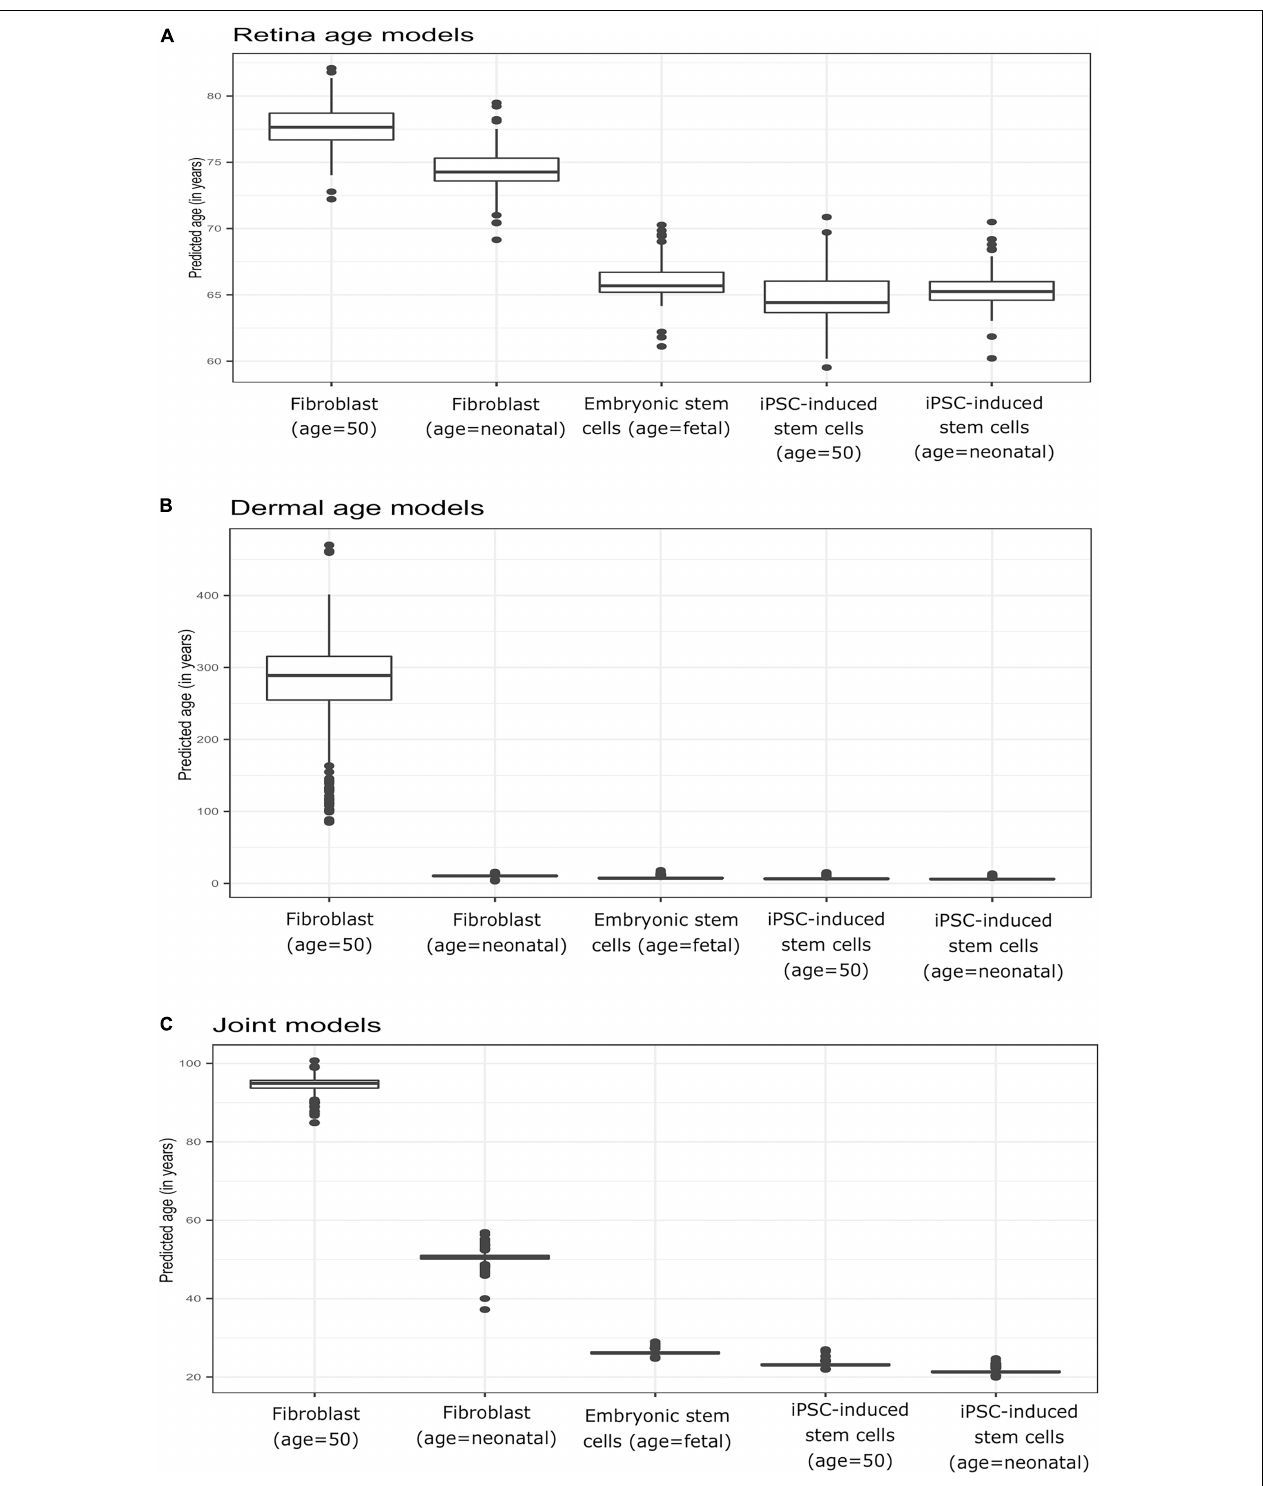
FIGURE 4 | Boxplots of predicted age (group-wise) in Primary fibroblast samples, primary embryonic stem cells, and induced pluripotent stem cells (iPSC). Shown are estimates obtained with clocks developed using (A) retina (AMD MGS1) tissue, (B) dermal fibroblast samples, and (C) combined retina-dermal datasets for the set of 5,321 common genes. The five groups consisted of fibroblasts from neonatal individuals (FN1, FN2), induced pluripotent stem cells (iPSC) derived from fibroblasts from neonatal individuals (IN2.1, IN2.2, IN2.4, IN2.5), fibroblasts from 50 year old individuals (F50, F50S), induced pluripotent stem cells (iPSC) derived from fibroblasts from 50 year old individuals (I50.2, I50.3, I50S.1, I50S.2) and embryonic stem cells (H1, H9) samples, respectively.